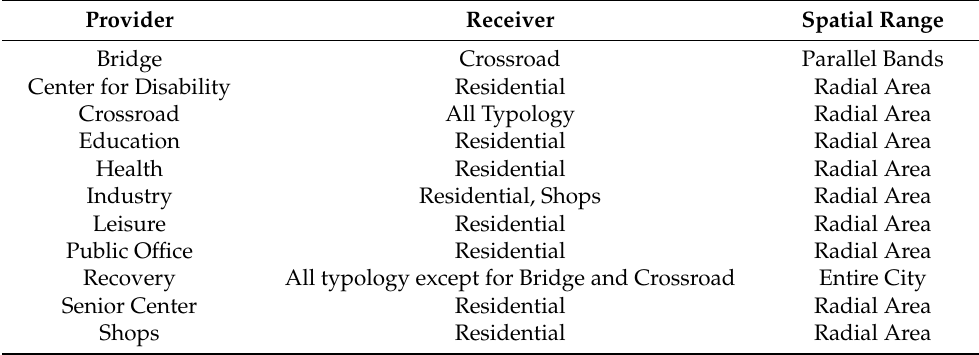
Table 3. Spatial ranges employed for establishing